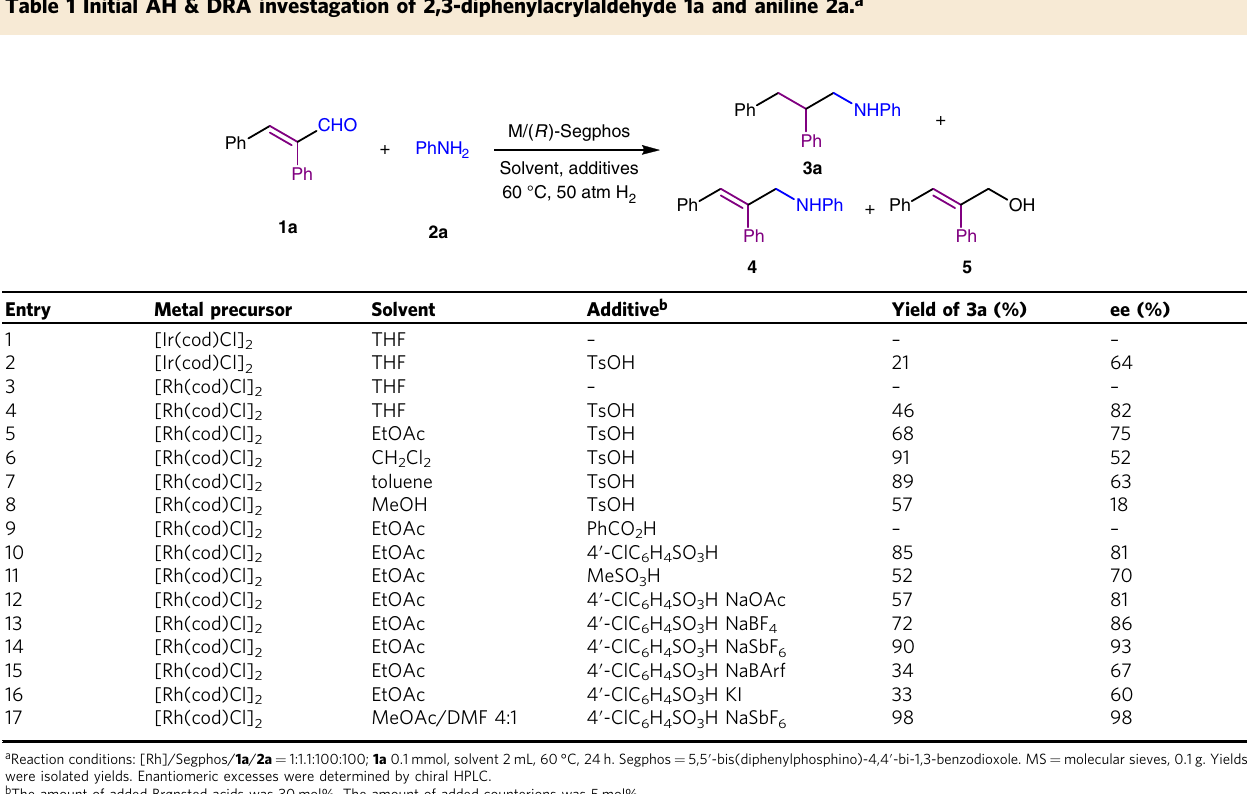
Table 1 Initial AH & DRA investagation of 2,3-diphenylacrylaldehyde 1a and aniline 2a. a